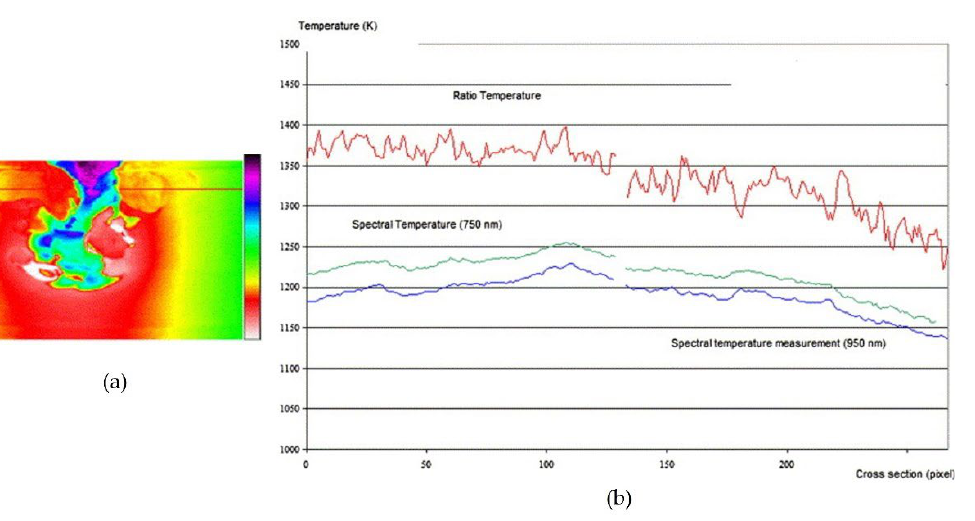
Figure 11. ( a ) Thermal image of a copper sample heated up to its fusion point. ( b ) Temperature profiles along the red horizontal line. The red curve was obtained through radiation ratio method, while the green and blue curves were obtained with spectral temperature method at 750 nm and 950 nm, respectively [40].